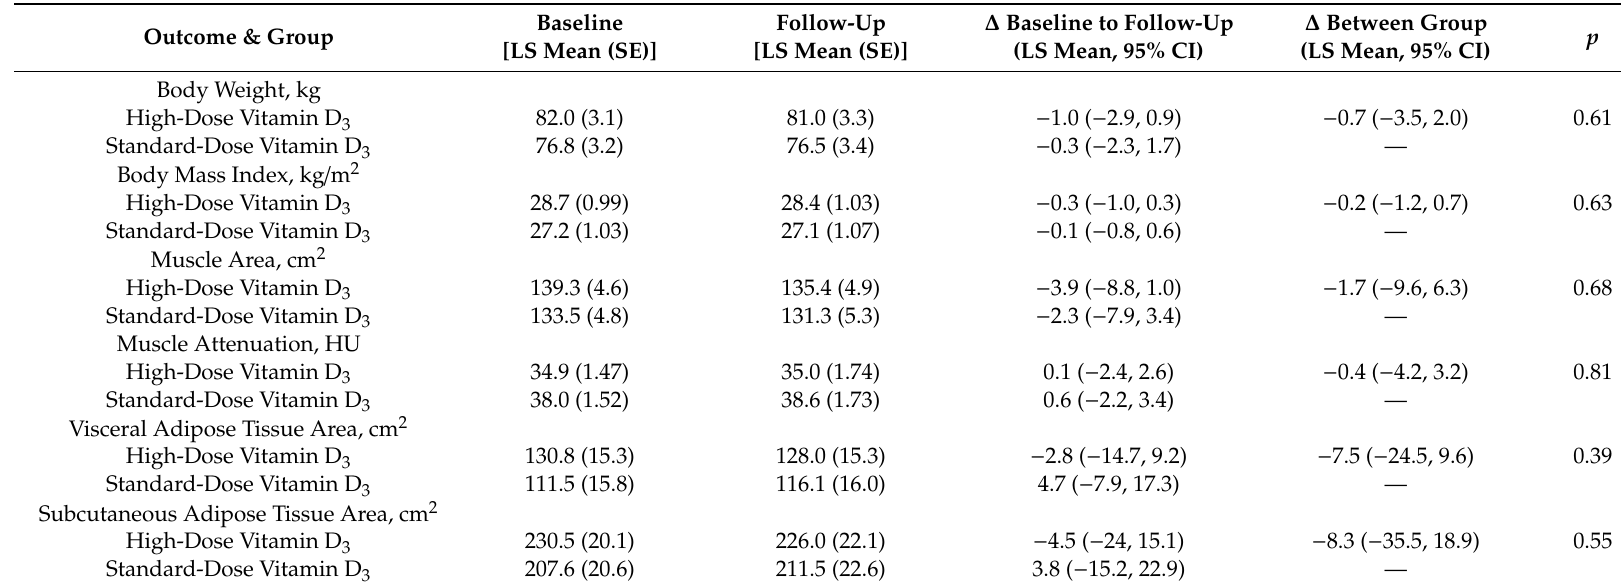
Table 2. E ff ects of vitamin D 3 supplementation on change in body composition outcomes using multiple imputation